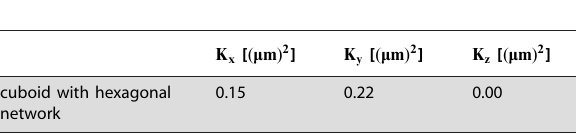
Table 4. Calculation of permeability field of the cuboid shown in Figure 6.